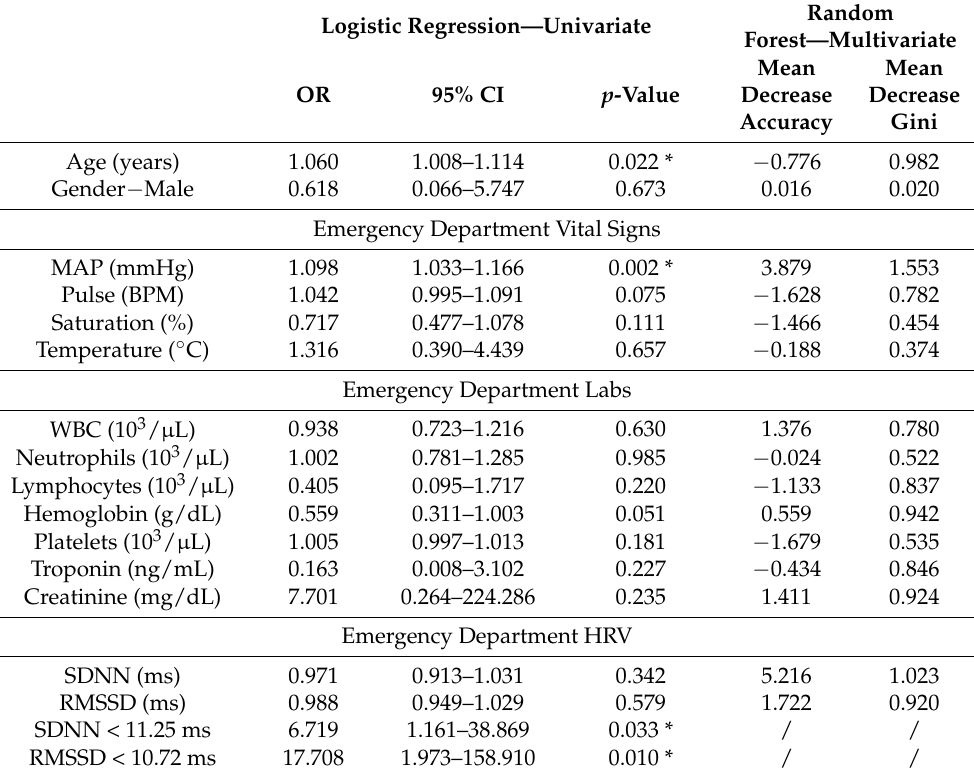
Table 2. New HFrEF of severe degree (per echo)—logistic regression and random forest classifiers. Logistic Regression—Univariate Random Forest—Multivariate